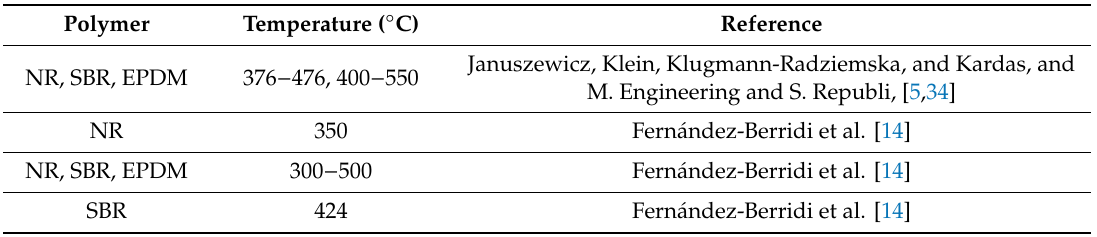
Table 3. Rubber materials pyrolysis degradation temperature in ◦ C. Polymers: NR = Natural